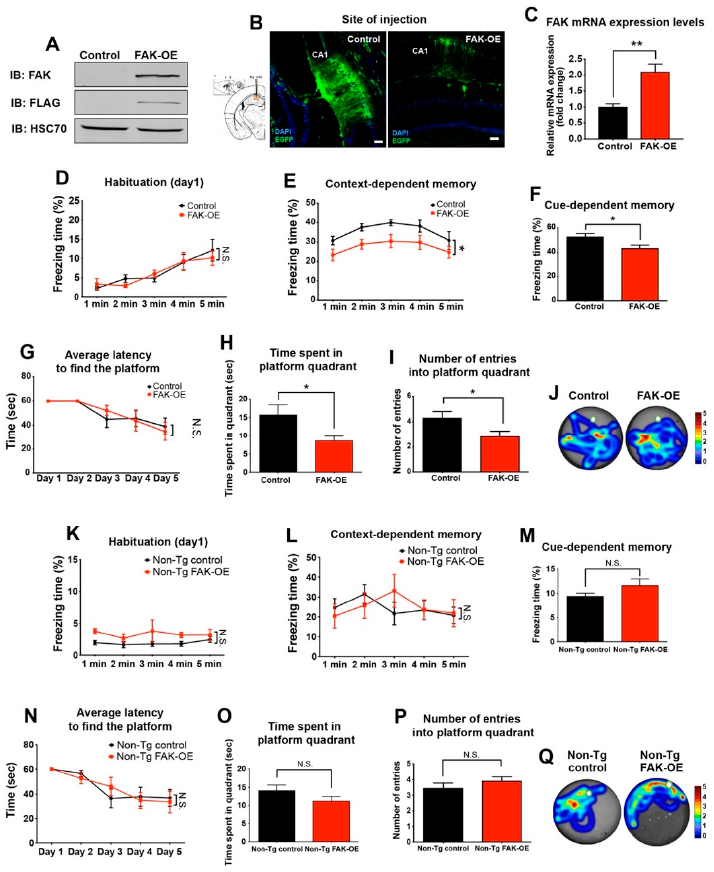
Figure 2. Overexpression of FAK in 3xTg-AD mouse hippocampus leads to significant impairment in learning and memory. Panels ( A – J ), 3XTg-AD mice; panels ( K – P ), non-Tg, wild-type mice. ( A ) HEK293T cells were transfected with FLAG-tagged control viral vector or a vector expressing FAK (FAK-OE), expression was verified by immunoblot analysis. ( B ) Left, diagram of the coordinates for site injection of CA1 region from the Allen mouse brain atlas. Right, representative confocal images of control and FAK-OE hippocampi. Green, EGFP; blue, DAPI. Scale bar, 100 μ m. (C) FAK mRNA expression levels in hippocampi of 3xTg-AD mice injected with control or FAK expressing lentiviral vector. N = 5 mice per group, ** p = 0.0043 by an unpaired Student’s t -test. ( D ) Freezing response during habituation on the first day of fear conditioning paradigm. p = N.S. by two-way ANOVA with Bonferroni post hoc test. ( E ) Freezing response in context-dependent memory test. * p = 0.0175 by two-way ANOVA with the Bonferroni post hoc test. ( F ) Freezing response in cue-dependent memory test. * p = 0.0364 by an unpaired Student’s t -test. ( G ) Average latency to find the platform during 5 d of acquisition phase. p = N.S. by two-way ANOVA with the Bonferroni post hoc test. ( H ) Time spent in the platform quadrant during the probe test day. * p = 0.0281 by an unpaired Student’s t -test. ( I ) Analysis of the number of entries into the platform quadrant during the probe test day. * p = 0.0452 by an unpaired Student’s t -test. ( J ) Representative heatmaps of control and FAK-OE mice during the probe test day. n = 10 in each control and FAK-OE groups. ( K ) Freezing response during habituation on the first day of fear conditioning paradigm. p = N.S. by two-way ANOVA with the Bonferroni post hoc test. ( L ) Freezing response in context-dependent memory test. p = N.S. by two-way ANOVA with the Bonferroni post hoc test. ( M ) Freezing response in cue-dependent memory test. p = N.S. by an unpaired Student’s t -test. ( N ) Average latency to find the platform during 5 d of acquisition phase. p = N.S. by two-way ANOVA with the Bonferroni post hoc test. ( O ) Time spent in the platform quadrant during the probe test day. p = N.S. by an unpaired Student’s t -test. ( P ) Analysis of the number of entries into the platform quadrant during the probe test day. p = N.S. by an unpaired Student’s t -test. ( Q ) Representative heatmaps of control and FAK-OE mice during the probe test day. N = 10 in each control and FAK-OE